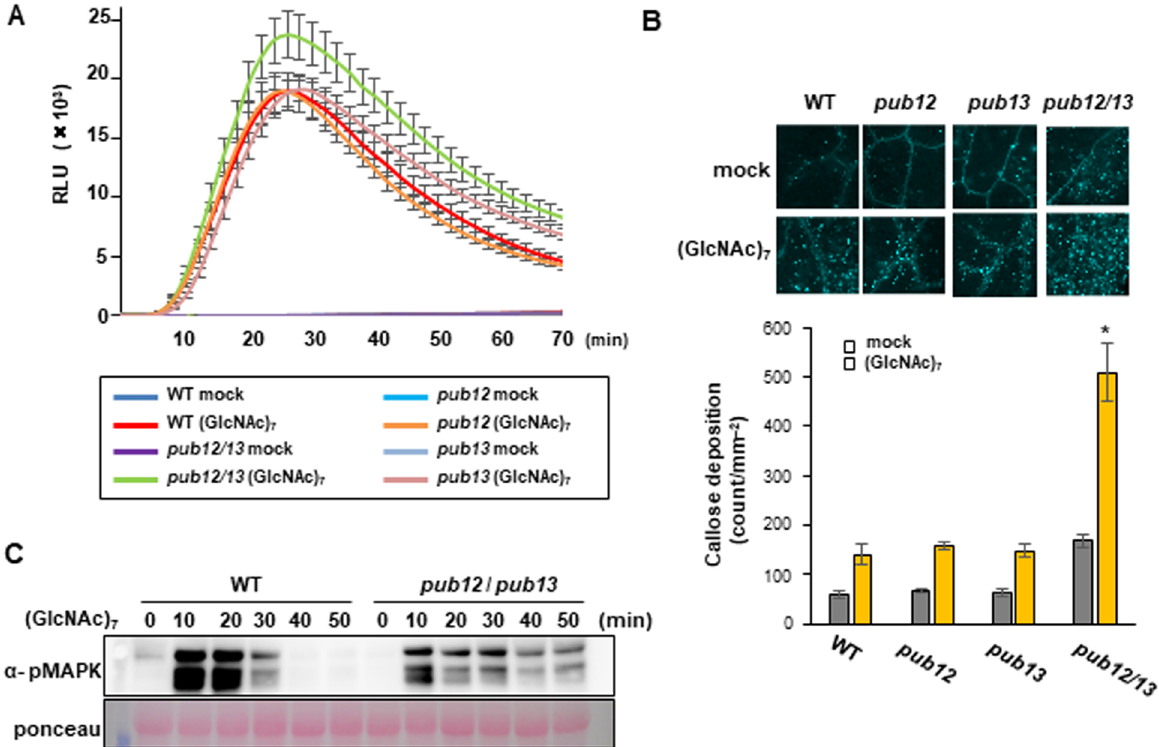
Fig 4. pub12 and pub13 double mutations enhance chitin-induced immunity. (A) ROS productionby 10-day-oldseedlings followinga treatment with 10 μ M (GlcNAc) 7 . Data are the mean ± SE (n = 10). (B) Chitin-induced callose deposition in the pub12 , pub13 ,and pub12/13 mutants. Ten-day-old seedlingswere treated with 10 μ M (GlcNAc) 7 for 18 h. Data represent the mean of 11 cotyledons ± SE. The asterisks indicate significantdifferences from the wild-type(WT) controls by Welch’s t -test ( P < 0.01). (C) Chitin inducedMAPK activationin pub12/pub13 mutants. Total proteinswere extracted from seedlings treated with 10 μ M (GlcNAc) 7 . The activationof each MAPK was analyzedby immunoblots with α -pMAPK. The protein loadingcontrol was shown by Ponceaustaining. Experiments were repeatedat least three times with similar